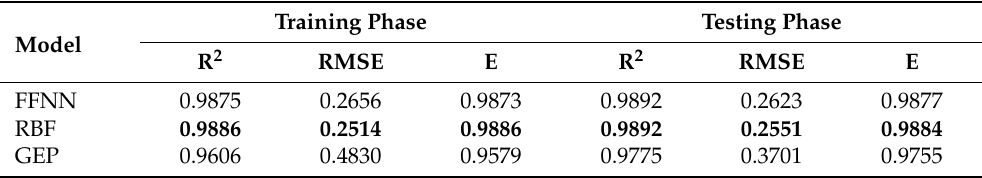
Table 11. Statistical criteria for the optimum combination of inputs.